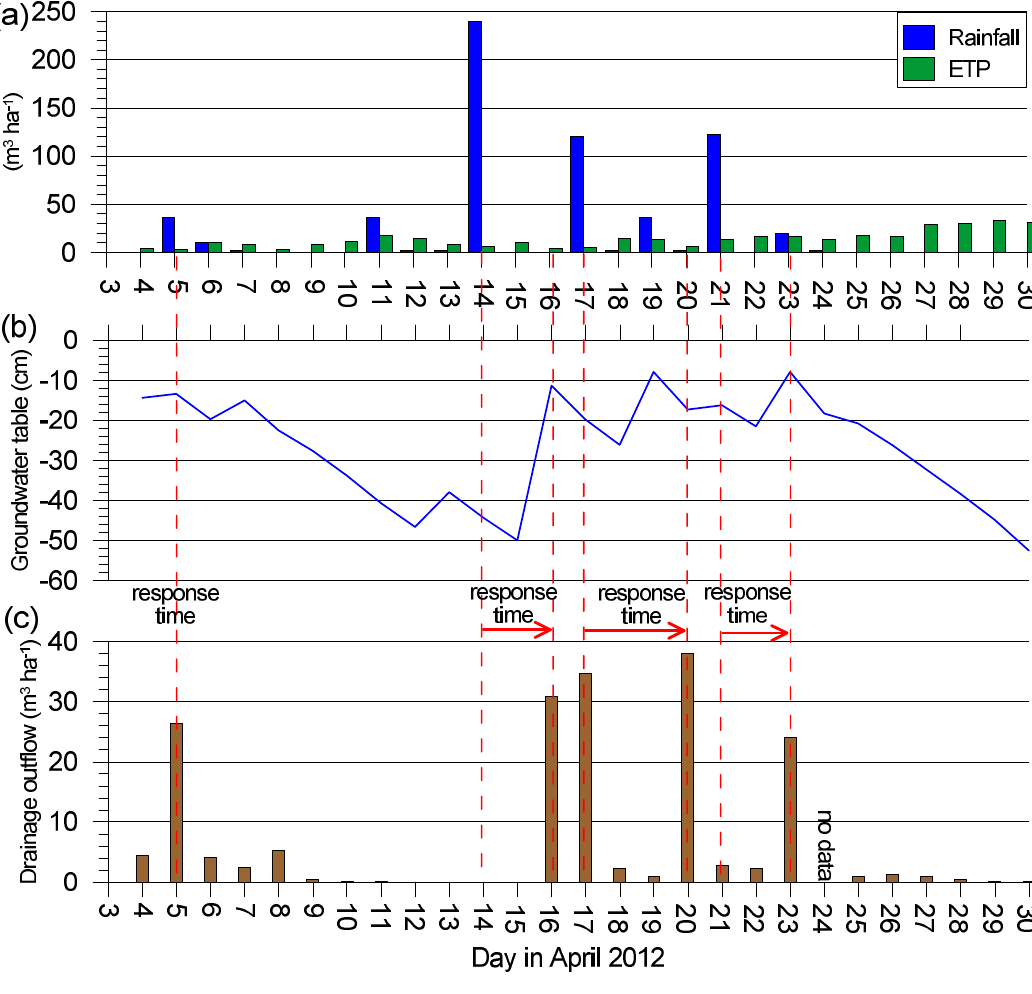
Figure 3. Daily precipitation and potential evapotranspiration (ETP) values ( a ), groundwater table ( b ), and drainage outflow ( c ) during the April 2012 observation period.